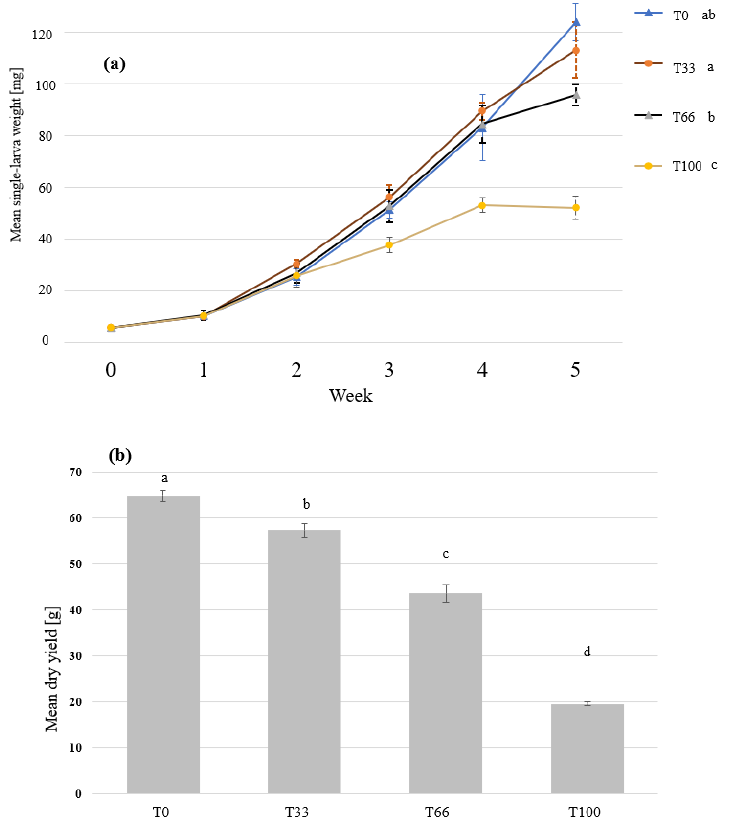
Figure 5. The growth and the final dry yield of mealworm larvae grown on substrates that contain different ratios of hemp material. Mealworm larvae were fed with wheat bran (T0), 67% bran and 33% hemp (T33), 34% bran and 66 hemp (T66), or 100% hemp (T100). The means and standard deviations of ( a ) the single ‐ larva fresh weight over time and ( b ) the final dry yield are shown in the graph. Repeated measures ANOVA with Greenhouse–Geisser correction (n = 5, p < 0.001, F = 1531.7), and Kruskal ‐ Wallis test (n = 5, p < 0.001) revealed significant differences in the larvae growth and final dry yield, respectively. Significant groups are indicated by the different letters.